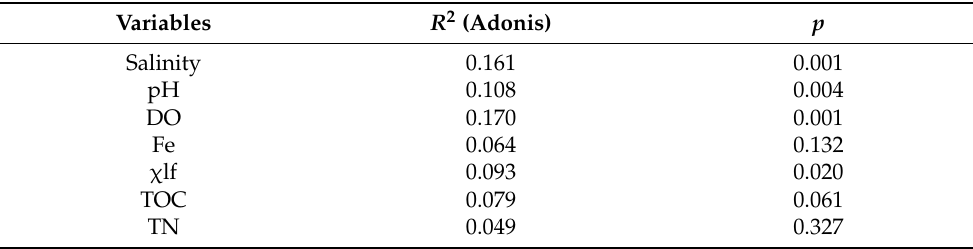
Table 2. Results from the PERMANOVA (adonis) model based on Bray-Curtis dissimilarity with 999